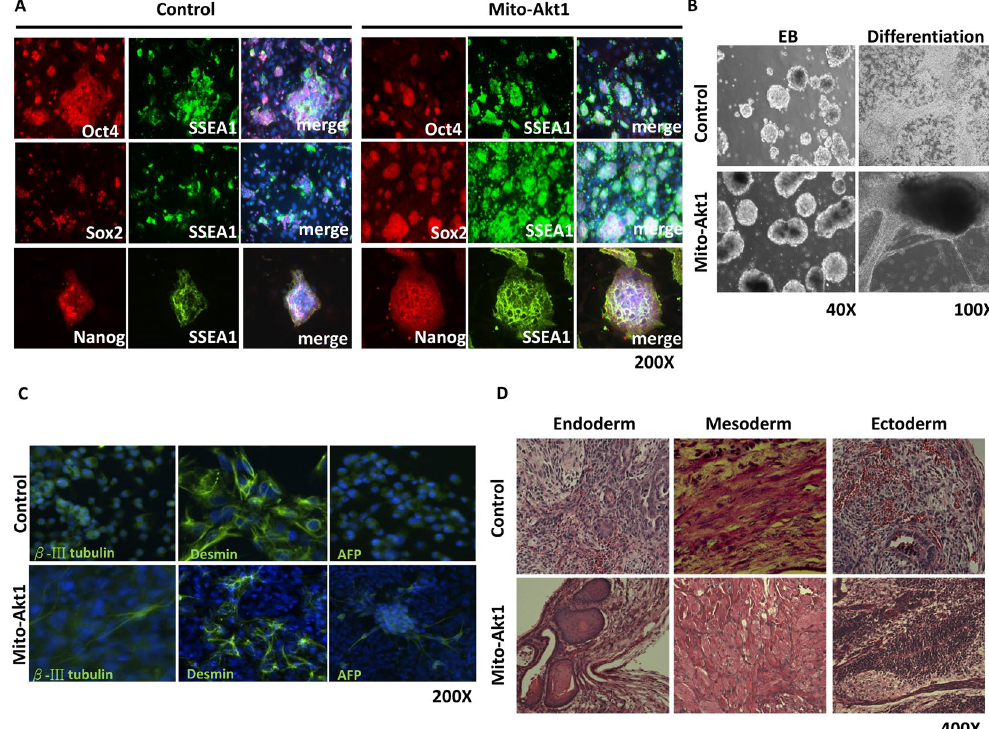
Figure 3. Characterization of iPSC pluripotency. ( A ) The iPSCs expressed embryonic stem cell surface markers. iPSC colonies derived from both groups were stained for SSEA1, Sox2, and Nanog. ( B ) In vitro differentiation assay. iPSCs from both groups were subjected to embryoid body formation. Embryoid bodies were plated onto 6 well plates, various cell types emerged from embryoid bodies. ( C ) The resulting tissues from EB were subjected to immunostaining with lineage markers of three germ layers. β III tubulin for ectoderm, Desmin for mesoderm and α -fetoprotein (AFP) for endoderm. Representative pictures were taken at 200X magnification. ( D ) In vivo differentiation assay. iPSC from both groups injected to SCID mice for teratoma formation. After 6 weeks, teratomas were sectioned and stained with Hematoxylin and Eosin. Representative photos of three germ layers are